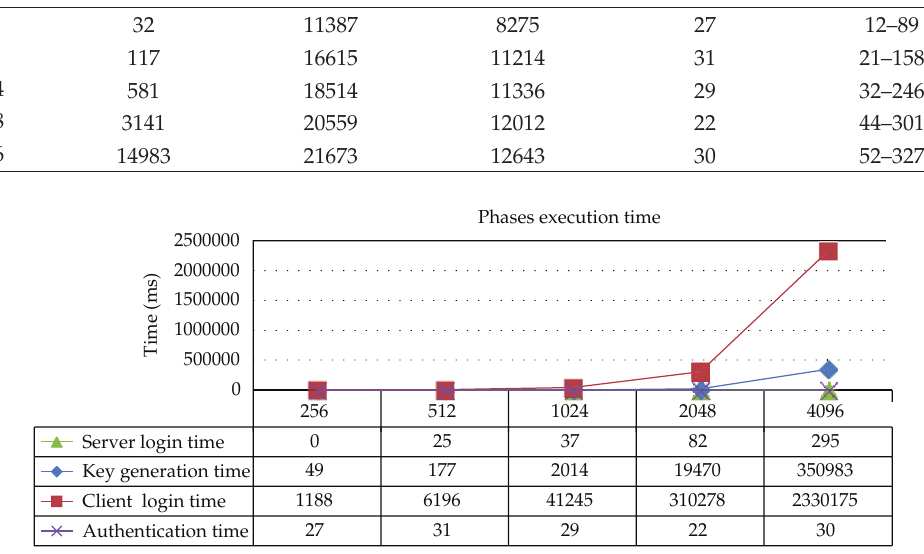
Figure 4: Comparison between phases in terms of execution